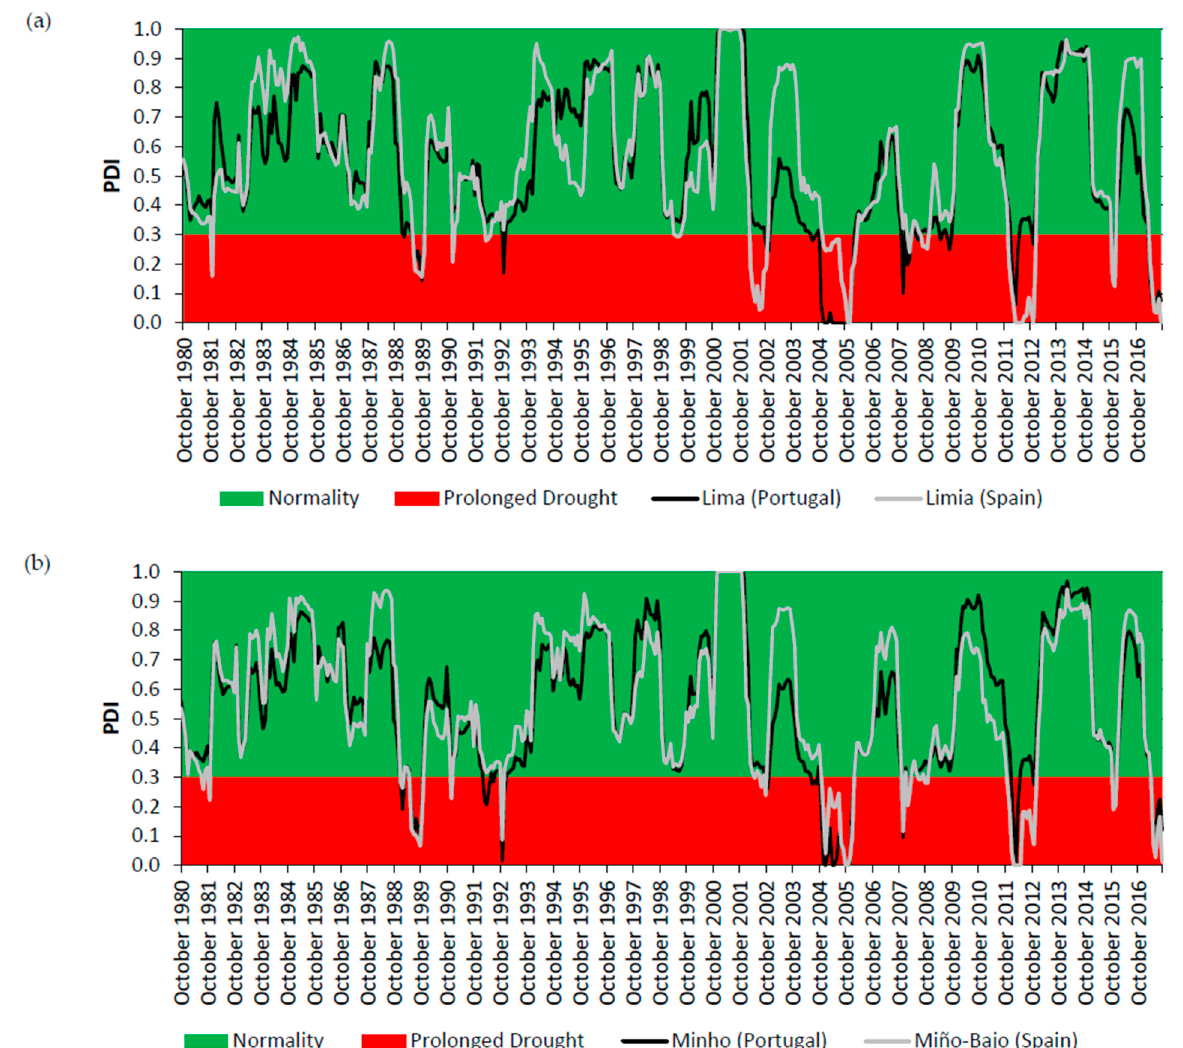
Figure 6. Prolonged Drought Indicator (PDI) for the period October 1980–September 2017 in ( a ) the Portuguese part (Lima) and the Spanish part (Limia) of the Lima river basin; and ( b ) in the Portuguese part (Minho) and the Spanish part (Miño-Bajo) of the Minho river basin.